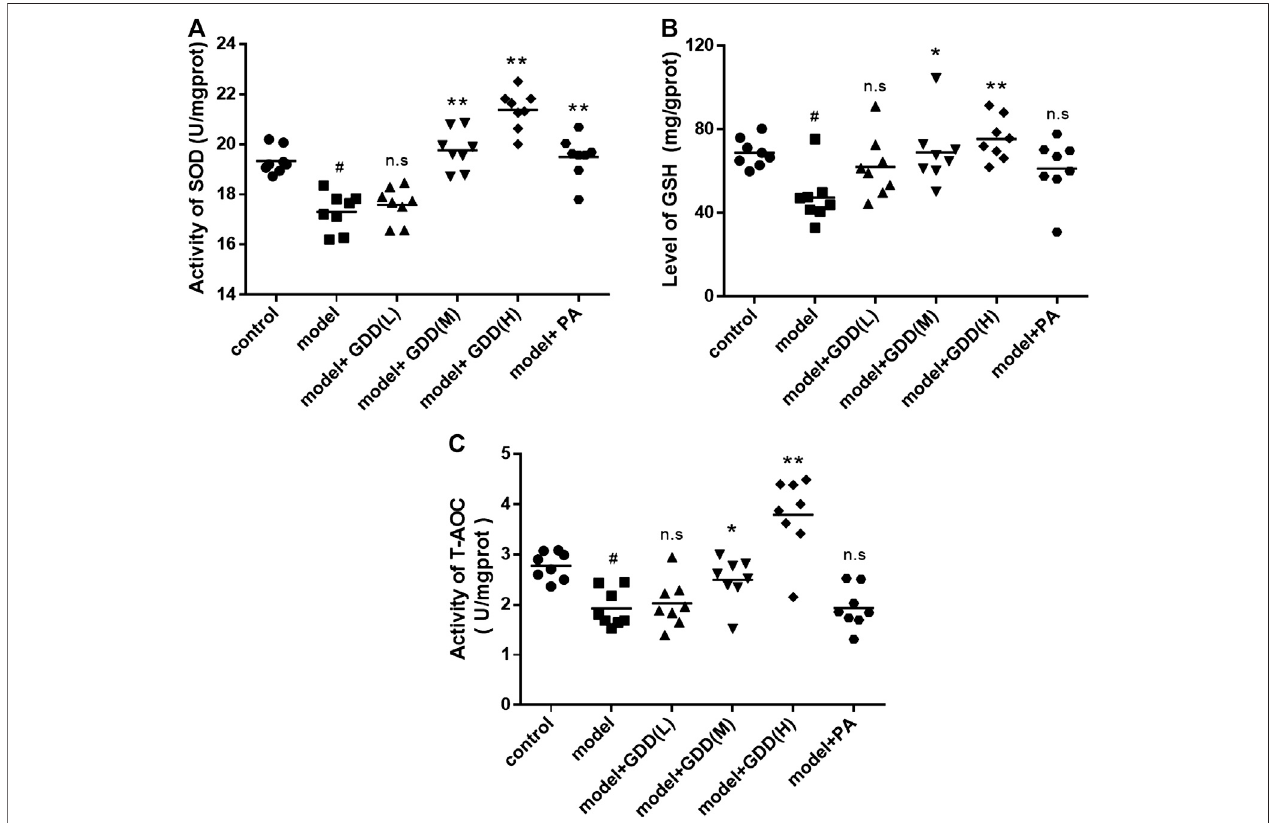
FIGURE 8 | Effects of GDD on levels of SOD (A) , GSH (B) , T-AOC (C) in the livers. # p < 0.01, compared with the control group; * p < 0.05, compared with model group; ** p < 0.01, compared with model group; n.s, not signi fi cant.